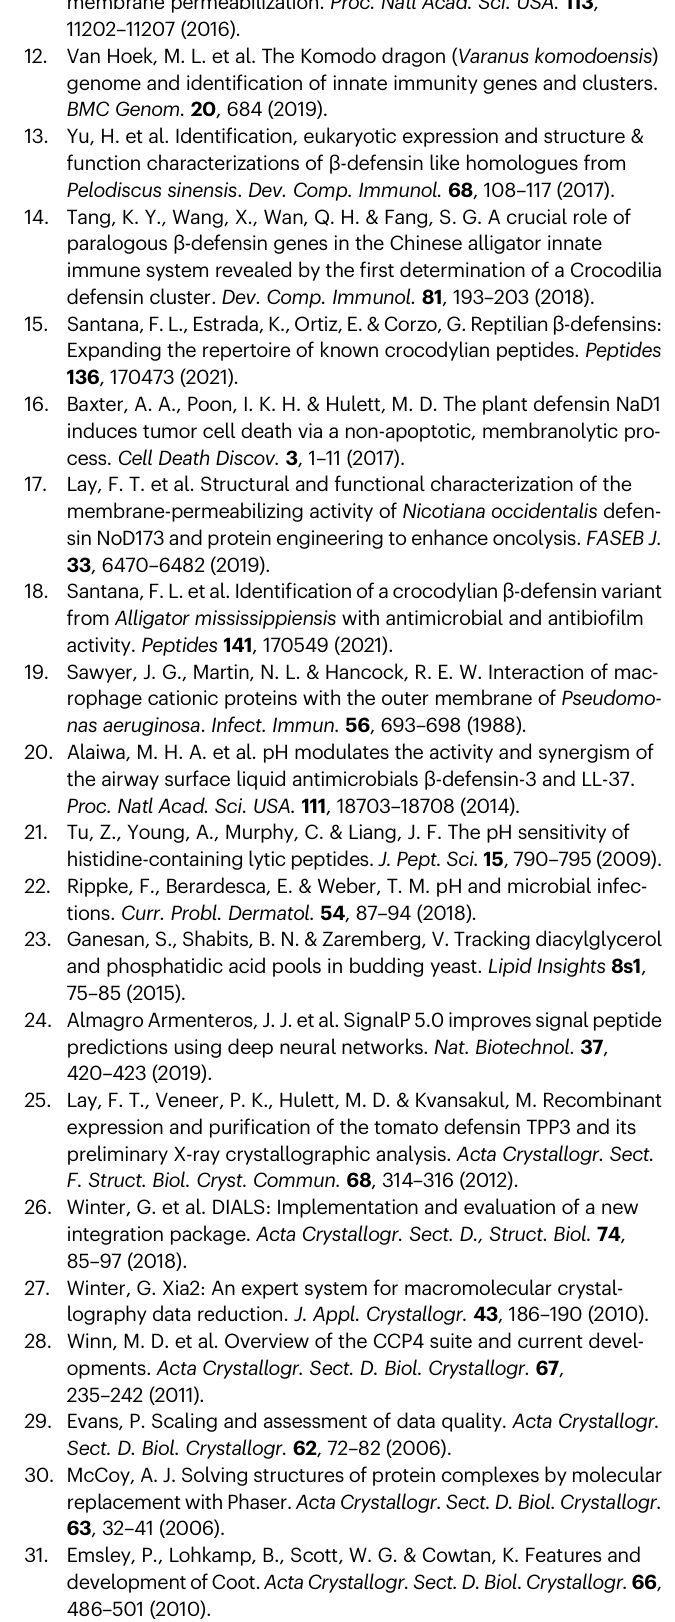
Table 1. Representative images of the electron density maps for both structures are presented in Supplementary Fig.